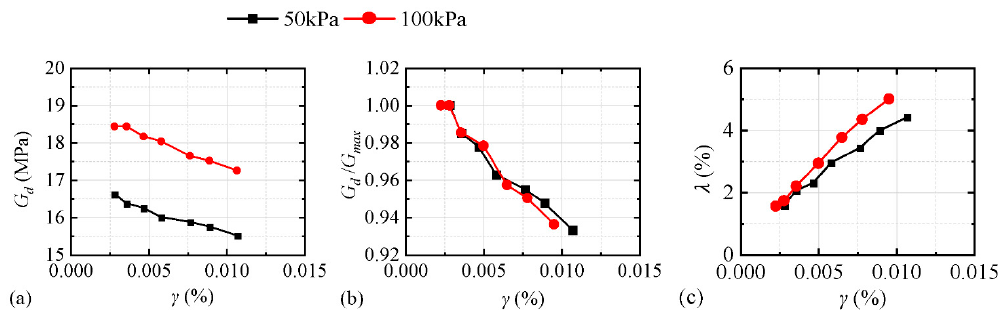
Figure 6. Test results of rubber granular soil:; ( a ) Dynamic shear modulus ( b ) Normalized dynamic shear modulus, ( c ) Dynamic damping ratio.